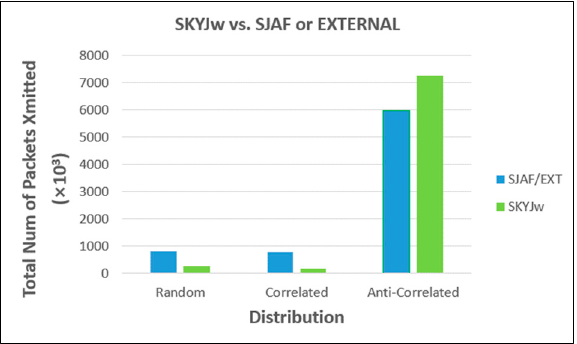
Figure 11. Comparison between EXTERNAL and SJAF.